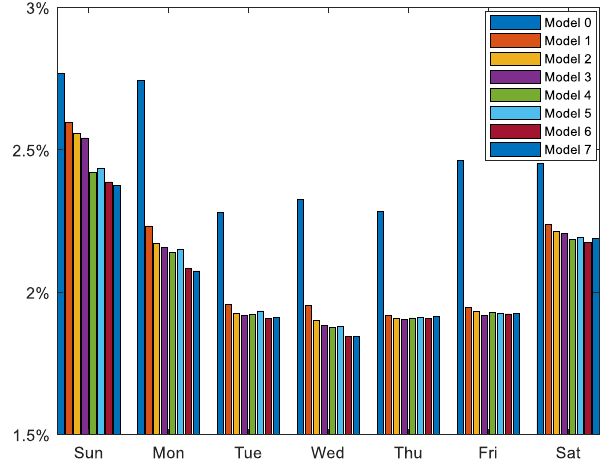
Figure 5. MAPE error of all seven models for the seven days of the week.